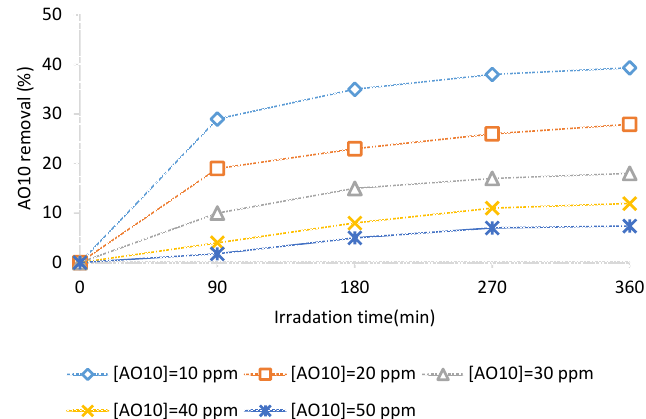
Fig. 11: Effect of initial concentration of AO10 on photo-oxidative removal of dye; [BiVO 4 ] = 0.25 g/100 mL, pH=3